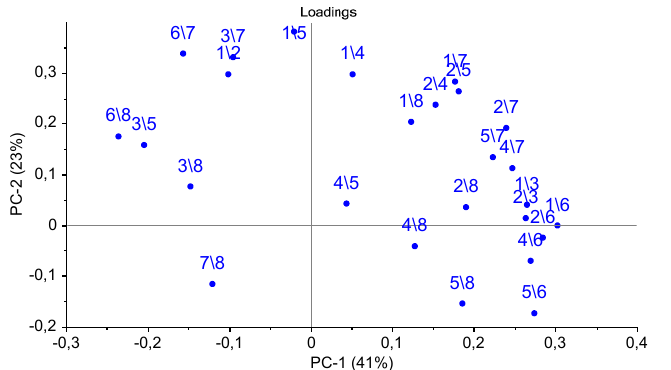
Figure 7. Loadings plot of the PCA model for samples of nasal swabs of calves by the spectra of the parameters of the cross mass-sensitivity A(i/j).